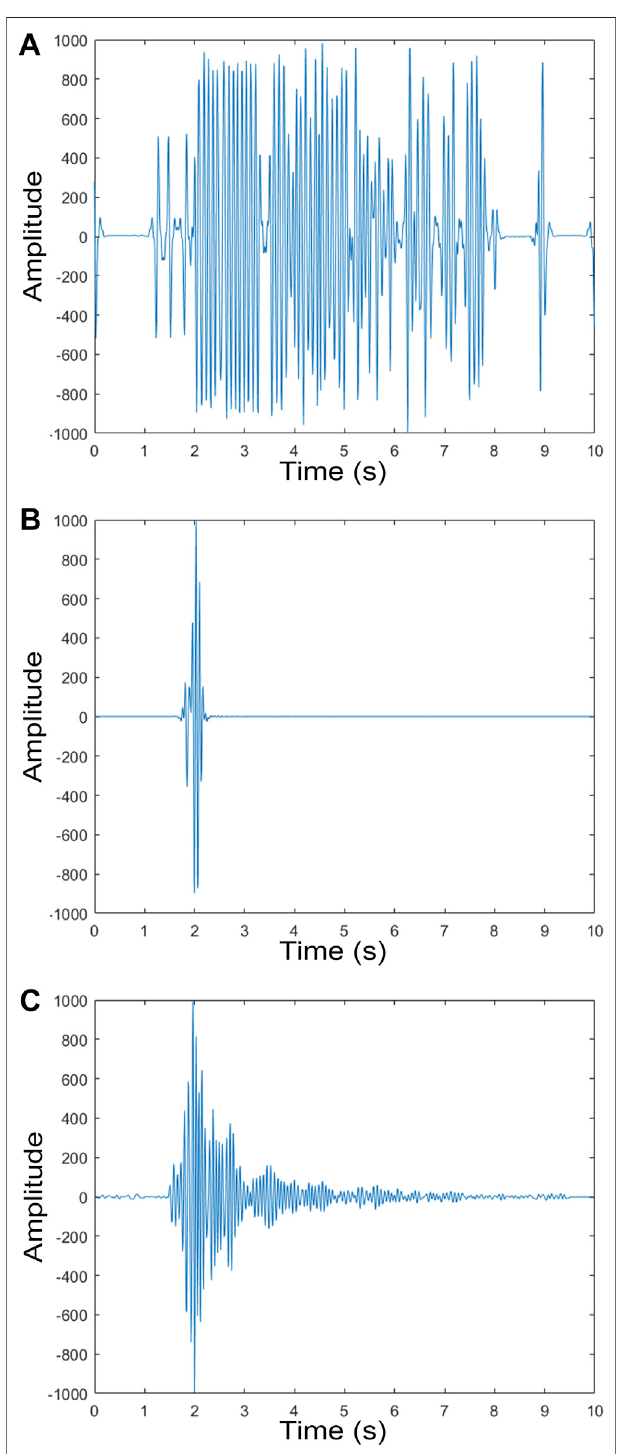
FIGURE 2 | Traces example. (A) : Trace with spurious signal; (B) : Trace with null values; (C) : Traces identi fi ed visually as being usable. All amplitudes are in